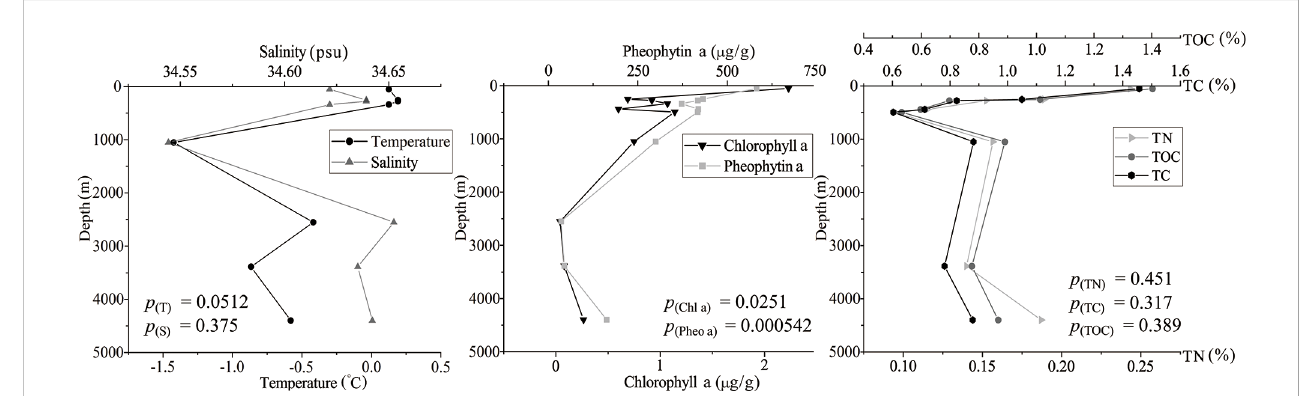
FIGURE 3 Pro fi les of bottom seawater temperature, salinity, and concentrations of chlorophyll a, pheophytin a, total nitrogen, total carbon and total organic carbon in the sediment samples. The correlations between the seven environmental variables with water depth were analyzed by the Spearman ’ s Rank Correlation Test. The results of statistical signi fi cance tests are shown at the bottom of each